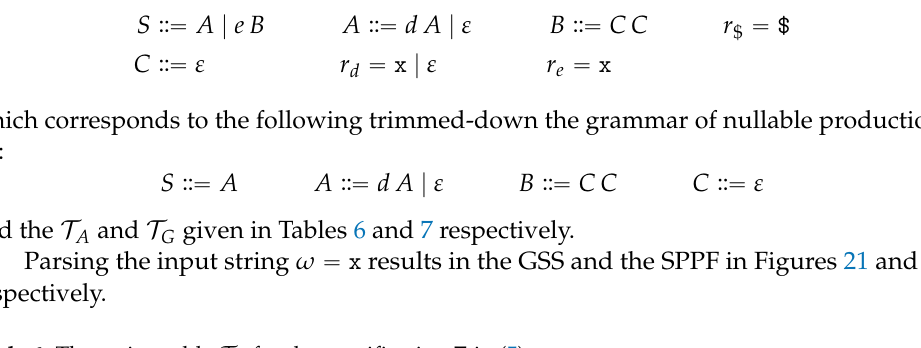
Table 6. The action table T A for the specification Ξ in